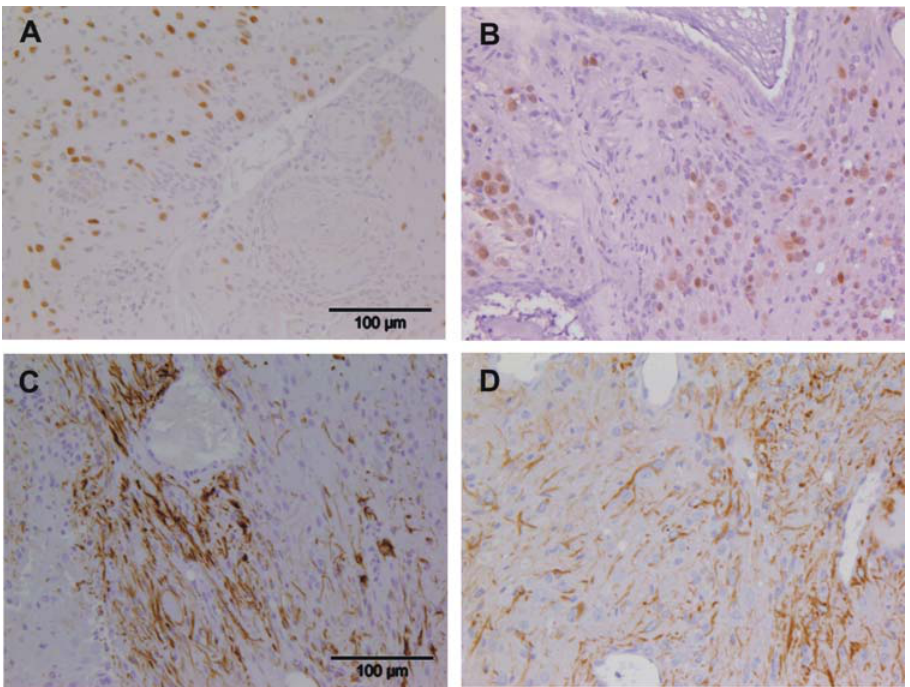
Figure 4. Immunohistochemical staining identifies neuronal and glial cells in teratomas derived from ES and invitro differentiated cells. The tumors were grown in SCID/beige mice after injection of ES cells (A, C) or after injection of in vitro differentiated cells (B, D). The teratomas were stained by immunohistochemistry for the neuronal marker NeuN (A, B) and the glial marker GFAP (C, D) which is mainly found in astrocytes. In the sections shown here, groups of cells positive for NeuN and confluent groups of cells positive for GFAP were